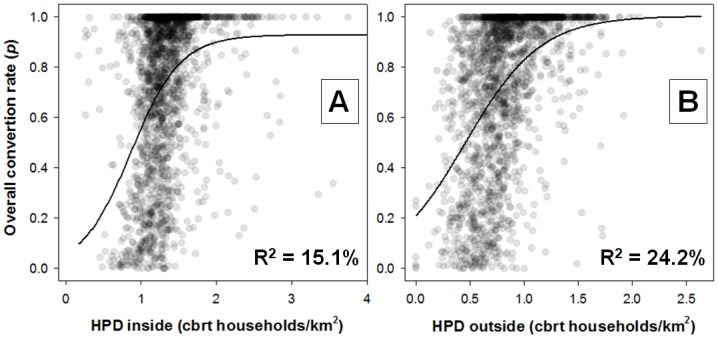
Human population density vs land conversion.Relationship between human population density (HPD), expressed in terms of the cubic root of households/km2, both (A) within and (B) outside INCRA settlement project areas and the proportion of natural forest, cerrado and grasslands in these areas that has been converted to any agropastoral land-use. R2-values, which represent best-fit lines from 3-parameter sigmoidal functions, indicate that landscape-scale HPD has played a greater role in driving historical vegetation conversion rates within settlement areas than the density of families of small farmers who were actually relocated into those settlements.